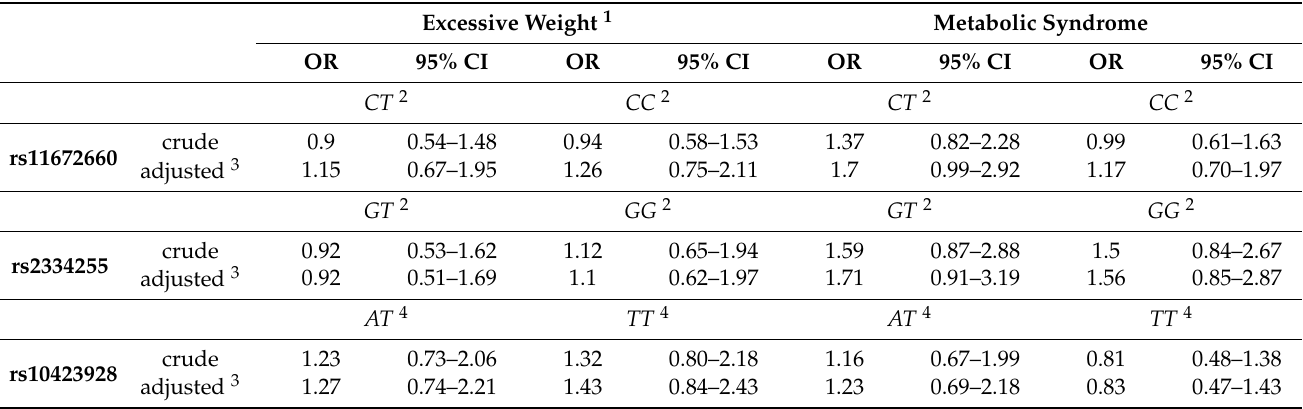
Table 4. Logistic regression investigating the association of rs11672660, rs2334255 and rs10423928 variants with excessive weight and metabolic